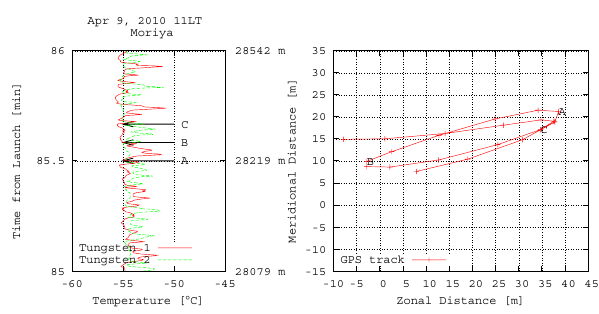
Fig. 6. Left: Temperature variations simultaneously measured by a paired tungsten sondes attached to a plate with the sensor arms directed to the opposite side (see Fig. 5). The ordinate is the time (min) after launch around 11:00a.m. on 9 April 2010 at Moriya, Japan (35.93 ◦ N, 140.00 ◦ E), covering the altitude range from 28.1 to 28.5km. Right: Horizontal projection of the sonde trajectories covering the altitude range specified by A, B and C in the left panel. 1200-gr balloon with the suspension line of 30m is